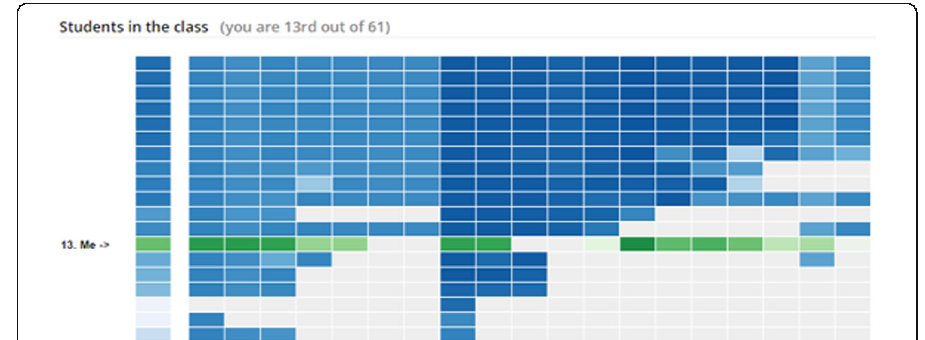
Fig. 4 The student list in the OSLM interface